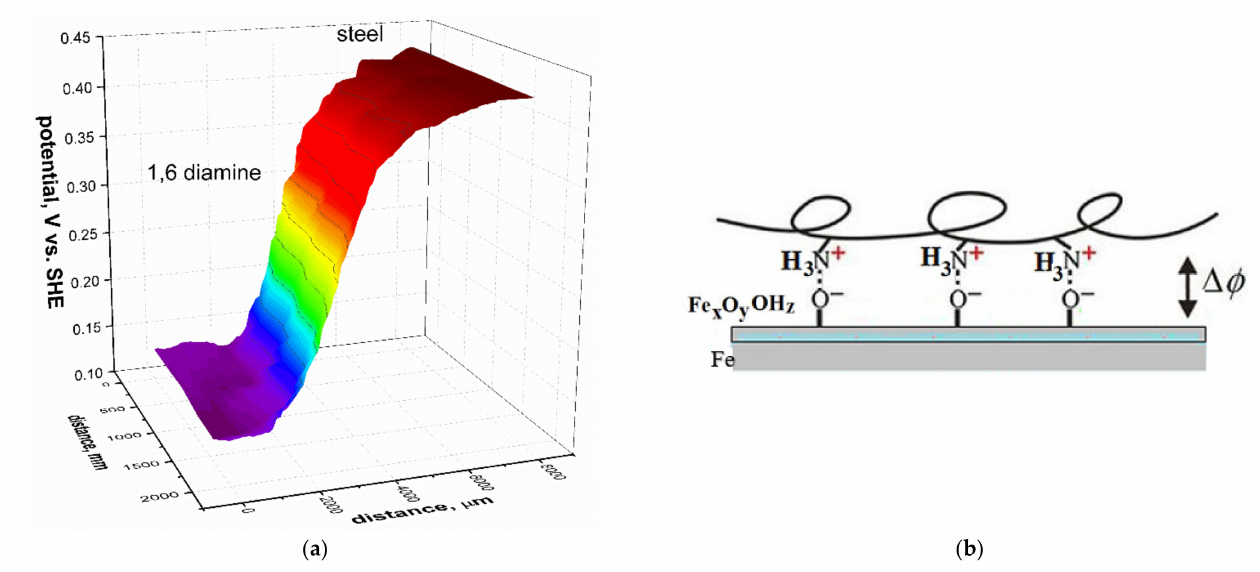
Figure 7. ( a )—Potential distribution across iron surface partially covered by 1.6 diaminohexane (left-hand side), ( b )—the schematic of charge distribution for Fe surface contacting with amino-containing polymer [11,41].